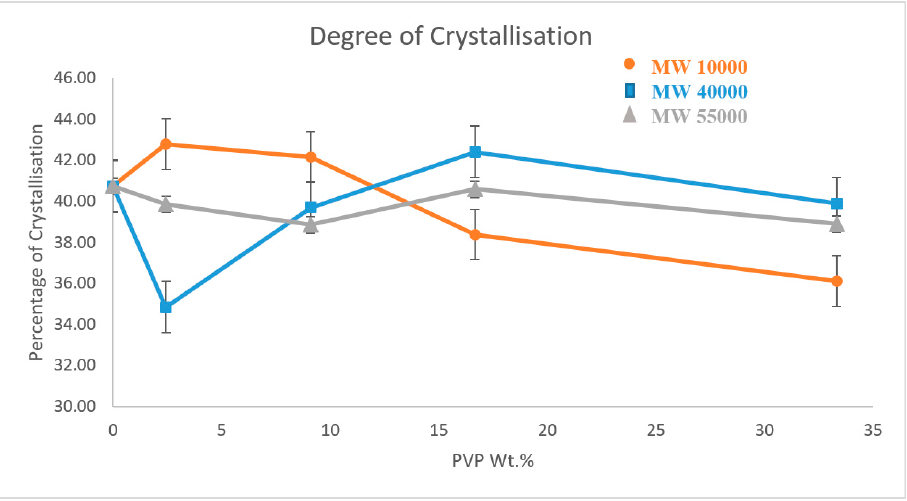
Figure 6. Crystallisation vs. wt % of PVP@MWNT/PVDF composite.